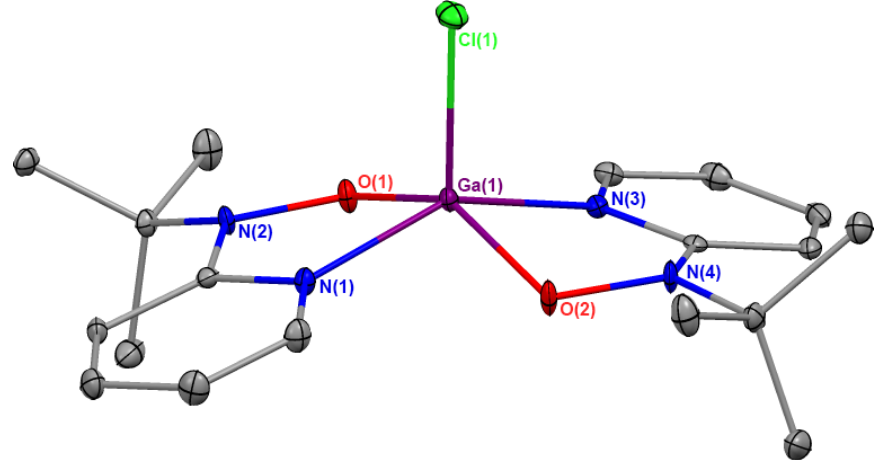
Figure 2. Solid state structure of (pyNO − ) 2 GaCl ( 1 ). Ellipsoids are projected at 30% probability and H atoms are omitted for clarity.